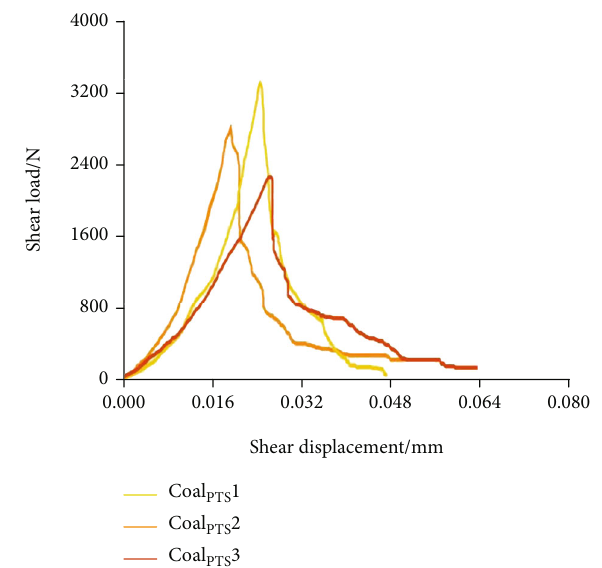
Figure 5: Curves of shear load displacement for specimens of coal